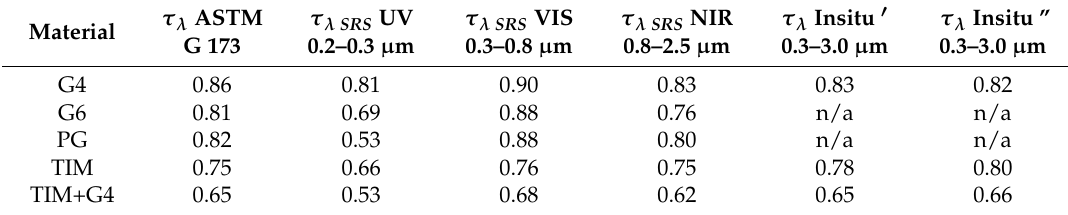
Table 5. Total solar transmittance values τ λ